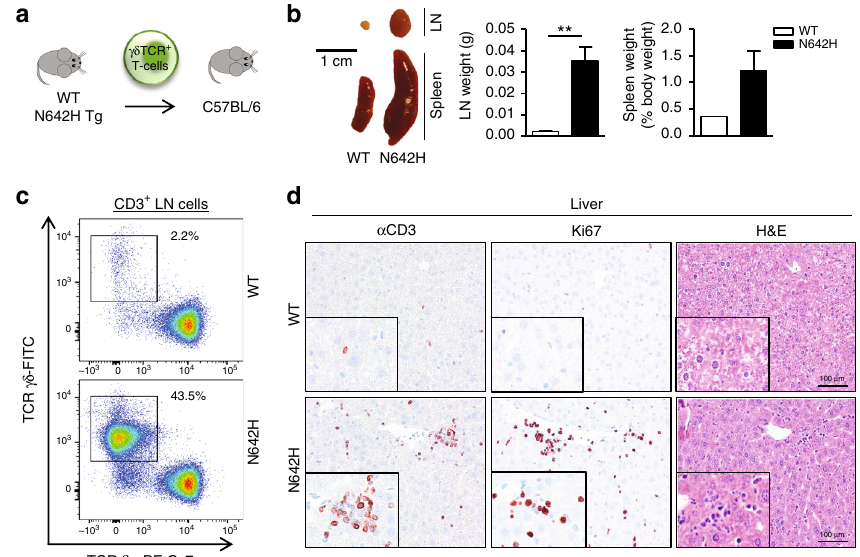
Fig. 4 STAT5B N642H transforms γδ T-cells, giving rise to aggressive γδ T-cell leukemia/lymphoma. a Schematic of isolation and transplantation of γδ T- cells from wild-type (WT) or hSTAT5B N642H transgenic (Tg) mice into C57BL/6NRj recipient mice (WT n = 4, N642H n = 6) by tail vein injection. Two out of six N642H γδ T-cell transplant mice showed signs of disease burden at 3 months post transplantation, and they were sacri fi ced and analyzed along with one healthy WT γδ T-cell transplant mouse. b Macroscopic comparison of lymph node (LN) and spleen size from recipient mice transplanted with γδ T-cells from hSTAT5B N642H ( n = 2) or WT ( n = 1) mice. Axillary, brachial, and inguinal LN and spleen weights were quanti fi ed and graphed as mean ± SEM, ** p < 0.01 by unpaired two-tailed Student ’ s t -test (LN), or mean ± range (spleen). c Flow cytometric analysis of the percentage of γδ T-cells in the LNs of recipient mice transplanted with γδ T-cells from hSTAT5B N642H ( n = 2) or WT ( n = 1) mice. d Histological analysis using CD3, Ki67, and H&E staining of the liver of recipient mice transplanted with γδ T-cells from hSTAT5B N642H ( n = 2) or WT ( n = 1) mice. Original magni fi cation: ×20 and ×40 (insets), scale bars = 100 μ m. Source data are provided as a Source Data fi (Fig. 5a). The structure was solved via molecular replacement with mouse STAT5A (PDB: 1Y1U) and re fi ned to R work and R free values of 0.266 and 0.306, respectively. Data collection and re fi nement statistics are summarized in Supplementary Table 1.